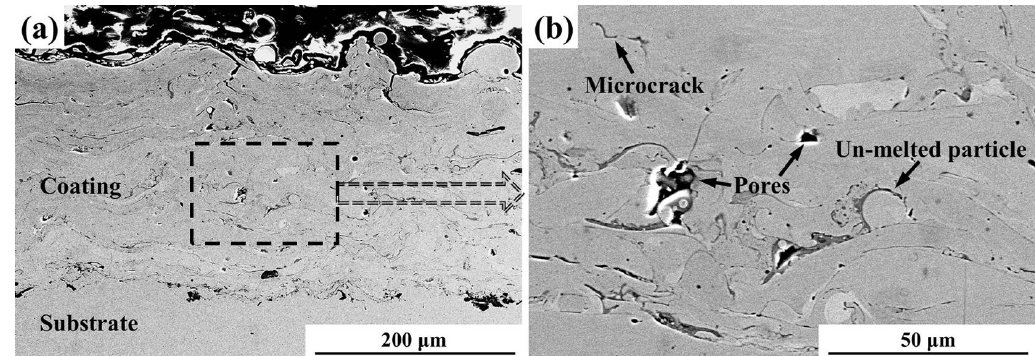
Figure 1. Scanning electron microscope (SEM) images of a transverse section of the as-sprayed coating: ( a ) an overall view morphology, and ( b ) a magnification of the rectangular frame in Figure